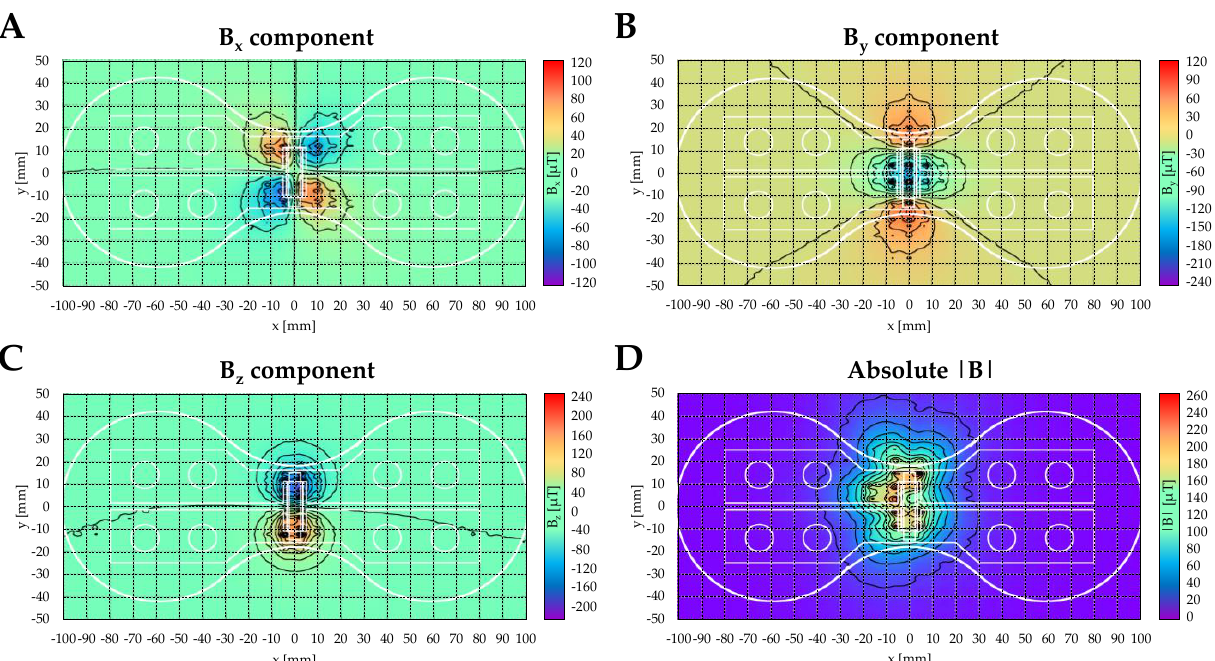
Figure 7. The AC magnetic field distribution of the applicator coil for all 3 directions and the absolute field approximately 4 mm above the coil. Heat maps summarize the distribution of the magnetic flux density: ( A ) B x component, ( B ) B y component, ( C ) B z component, and ( D ) absolute |B|. The measurement was taken with the recalibrated 3 axes PNI RM3100 sensor for a constant current (I = 0.1A) after subtracting the local earth magnetic field (I = 0 A).